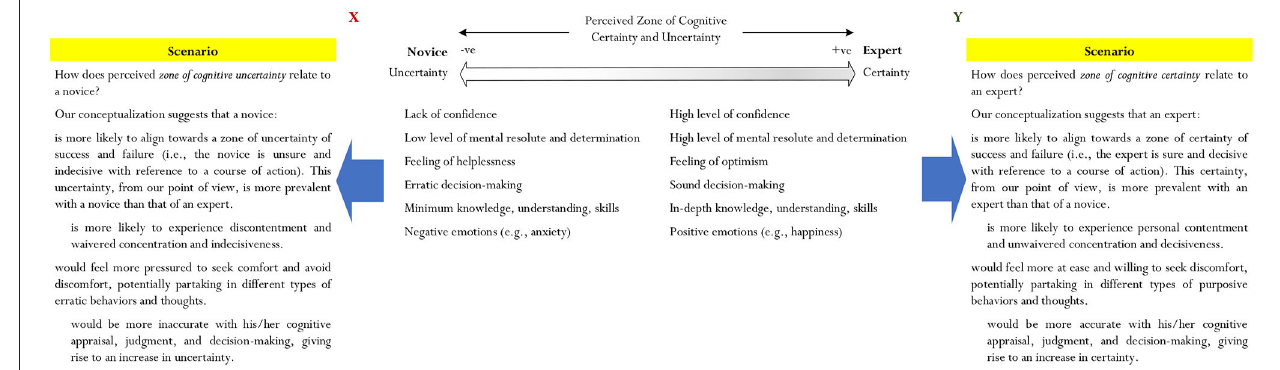
FIGURE 1 | A perceived zone of cognitive certainty and